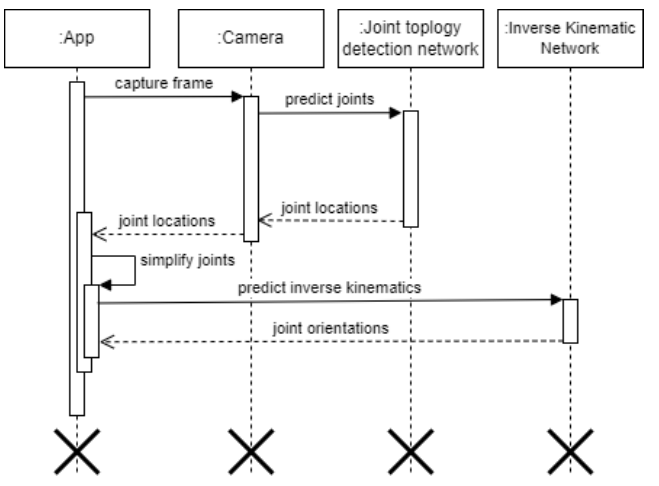
Figure 4. Estimation of a skeleton joint